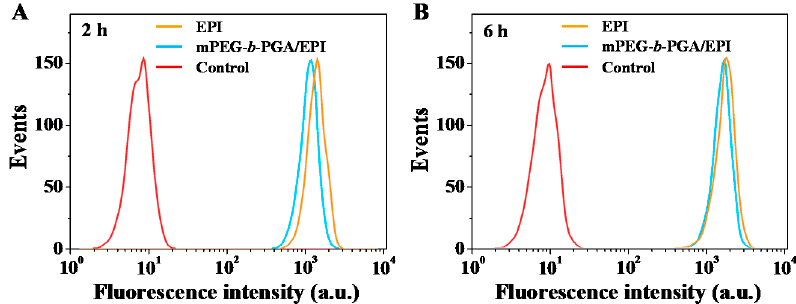
Figure 4. Cellular uptake microimages of HepG2 cells after incubation with free EPI or mPEG- b -PGA/EPI for 2 or 6 h. Scale bar: 25.0 μ m.